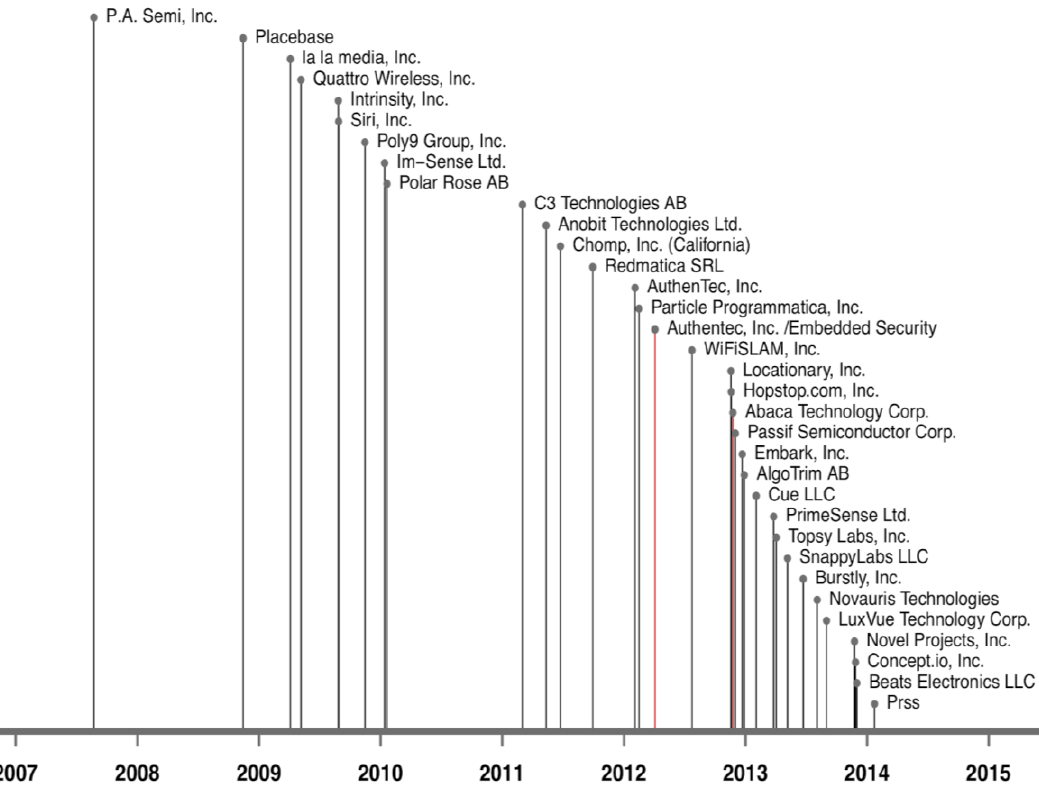
Figure 5: Acquisitions (black lines) and Divestitures (red lines) – Apple Inc.